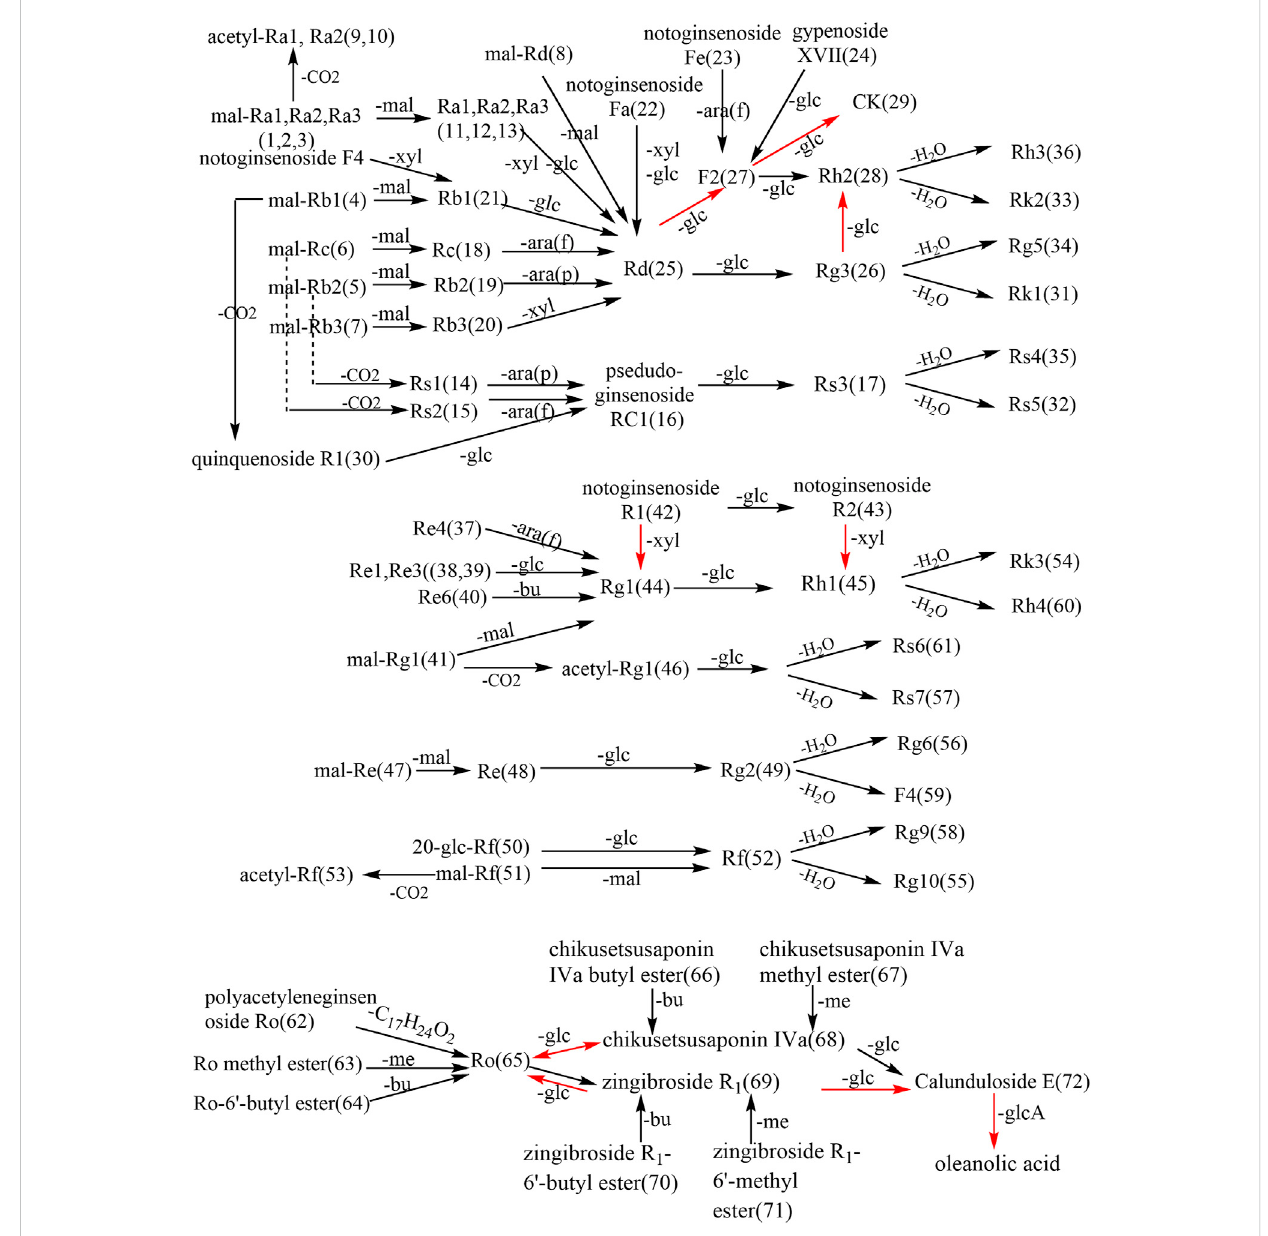
FIGURE 6 Transformation of ginsenosides in red ginseng products. (ara(f): α -L -arabinofuranosyl; ara(p): α -L -arabinopyranosyl; rha: α -L -ahamnopyranosyl; glc: β -D -glucopyranosyl; glcA: β -D -glucuronosyl; xyl: β -D -xylopyranosyl; mal:malonyl; bu: butyl. The red arrow represents biotransformation).